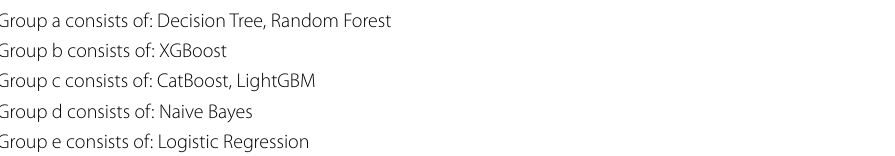
Table 16 HSD groupings of classifiers after 2-factor ANOVA where classifier and sampling ratio are factors with XSS web attacks; groups are by performance in terms of AUC Group a consists of: Decision Tree, Random Forest Group b consists of: XGBoost Group c consists of: CatBoost, LightGBM Group d consists of: Naive Bayes Group e consists of: Logistic